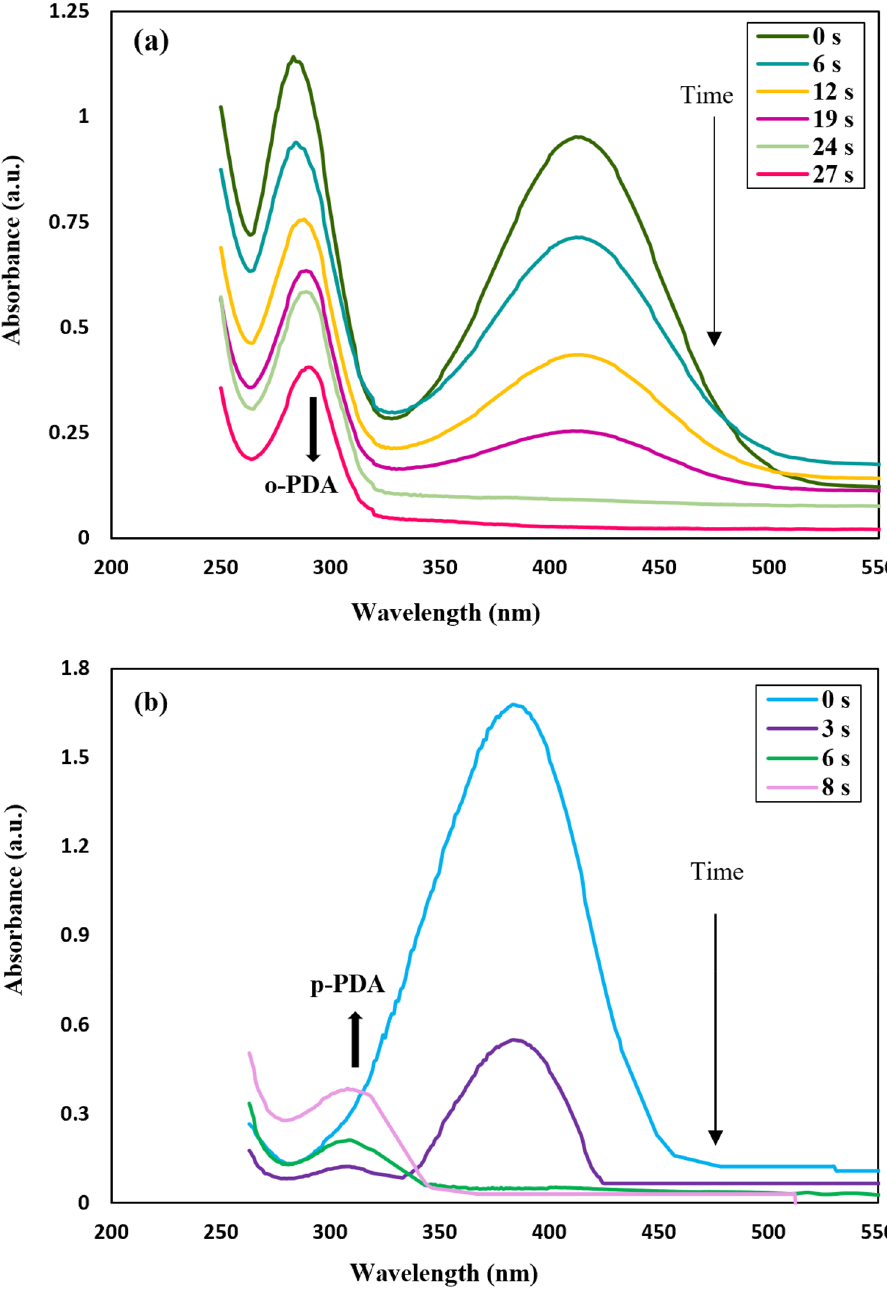
Figure 12. UV–Vis adsorption of ( a ) o-NA to o-PDA, ( b ) p-NA to p-PDA; after adding reductant of sodium borohydride and